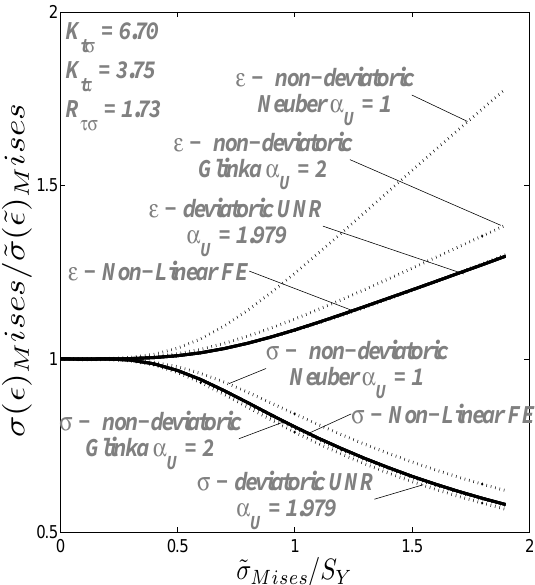
Figure 4: Predicted and FE-calculated EP strain and